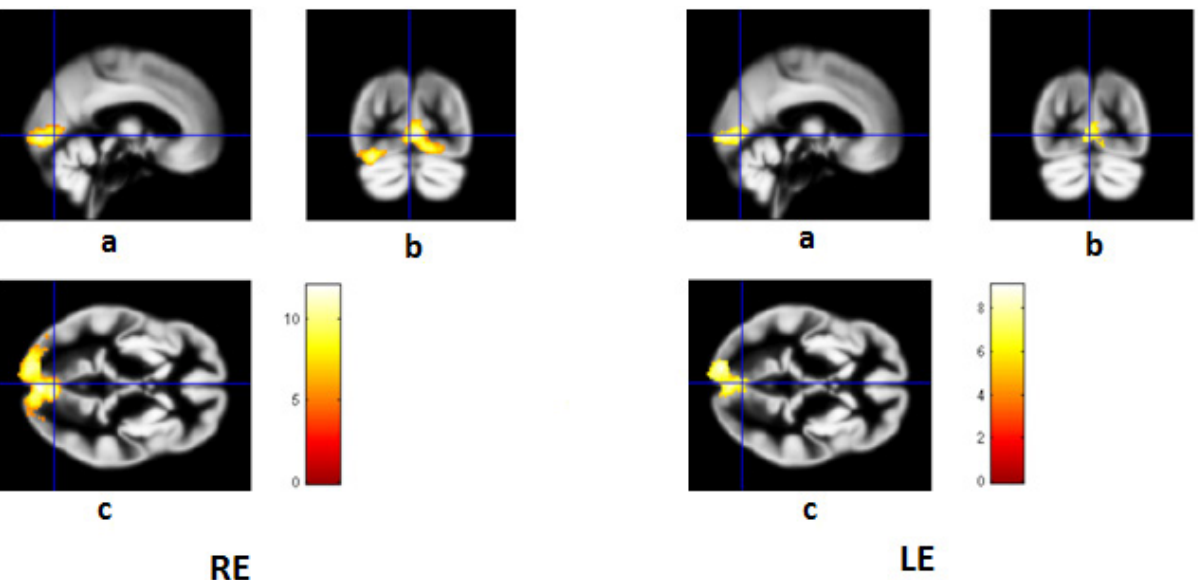
Fig. 1. Patient no. 1. Left eye Right eye. fMR 4900 voxel. Left eye. fMR 1600 voxel. Sagittal (a), coronal (b) and transverse (c)